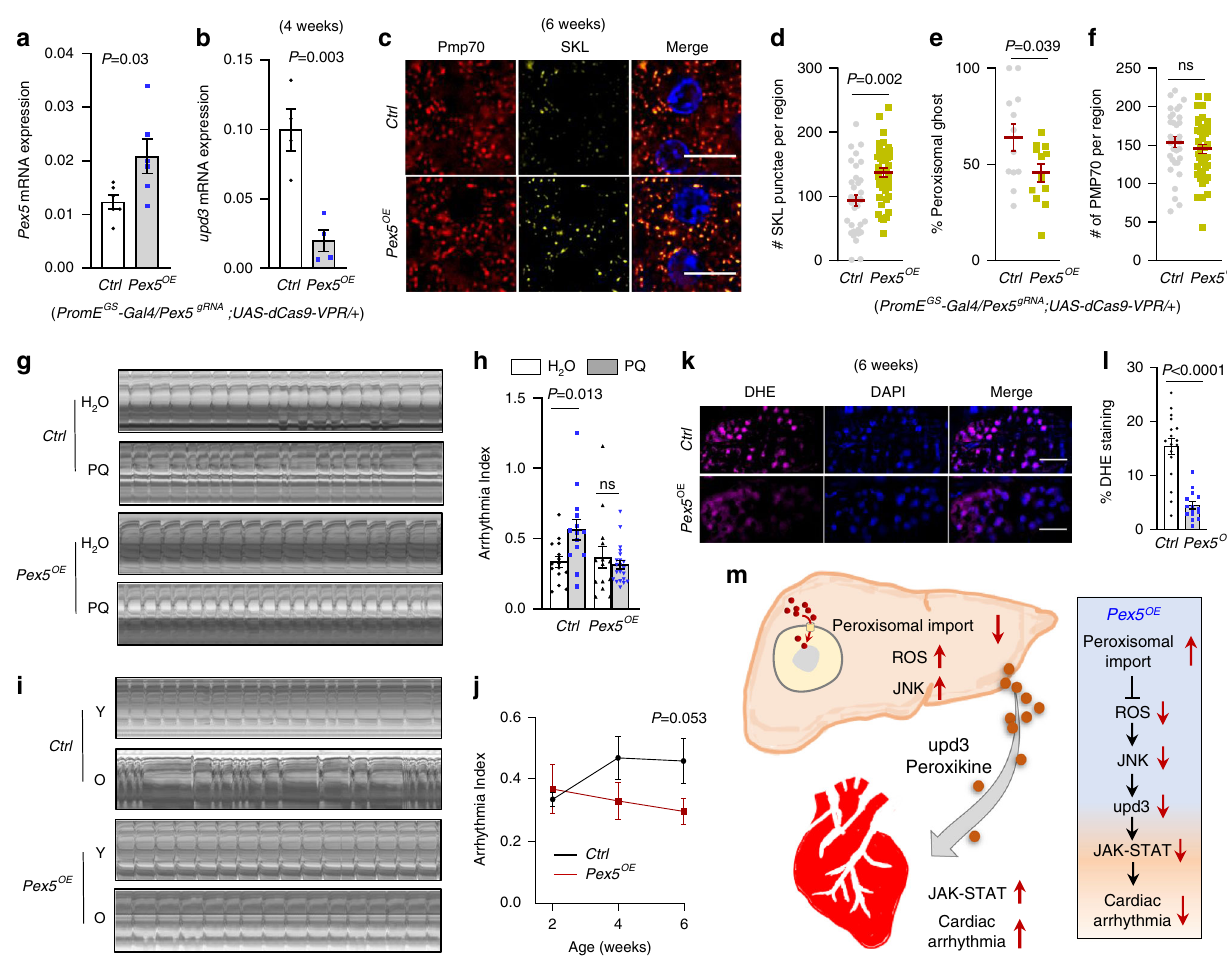
Fig. 7 Oenocyte-speci fi c Pex5 activation alleviates age-related PIS and preserves cardiac function. a QRT-PCR analysis showing expression of Pex5 in oenocytes dissected from fl ies with oenocyte-speci fi c overexpression of Pex5 . N = 3 biological samples from 2 independent experiments. b QRT-PCR analysis showing relative mRNA expression of upd3 in 4-week-old oenocytes dissected from fl ies with oenocyte-speci fi c overexpression of Pex5 . N = 4 independent biological samples. c Representative images to show co-localization of anti-Pmp70 and anti-SKL immunostaining in 6-week-old oenocytes dissected from fl ies with oenocyte-speci fi c overexpression of Pex5 (yellow dots). Scale bar: 6.7 µ m. d Quanti fi cation of SKL-positive punctae in c . Quanti fi cation of the percentage of peroxisomal ghosts (Pmp70-punctae with no SKL signals) per region of interest (166.41 µ m2) in c . f Quanti fi cation of Pmp70-positive punctae in c . d – f . Dot plot shows the quanti fi cations of 6 biological replicates, 6 ROIs per replicate. g Representative M-mode of fl ies with oenocyte-speci fi c Pex5 overexpression under paraquat treatment. h Arrhythmia index of fl ies with oenocyte-speci fi c Pex5 overexpression under paraquat treatment. (n left-right = 15,14,14,21 fl ies). i Representative M-mode of fl ies with oenocyte-speci fi c Pex5 overexpression during normal aging. j Arrhythmia index of fl ies with oenocyte-speci fi c Pex5 overexpression (red dots) during normal aging (2-week, 4-week and 6-week-old), n 0RU,y-o = 35, 15, 15 fl ies; n20 = 9, 15, 18 fl ies. k DHE staining in 6-week-old oenocytes from fl ies with oenocyte-speci fi c overexpression of Pex5 . Scale bar: 20 µ m. 0RU,y-o l Quanti fi cation of the percentage of DHE-positive staining in k . N = 6 fl ies, 3 ROIs per replicate. Ctrl genotype is PromE GS > Pex5 OE with no RU feeding. Data are represented as mean ± SEM. P values are calculated using two-sided unpaired t-test ( a , b , d – f , l , j ) or two-way ANOVA, followed by Holm-sidak multiple comparisons ( h ). m Proposed model to show that impaired hepatic peroxisomal import promotes ROS production, JNK activation, and peroxikine upd3 expression, which non-autonomously controls cardiac JAK-STAT and arrhythmia. Overexpression of endogenous Pex5 preserves cardiac